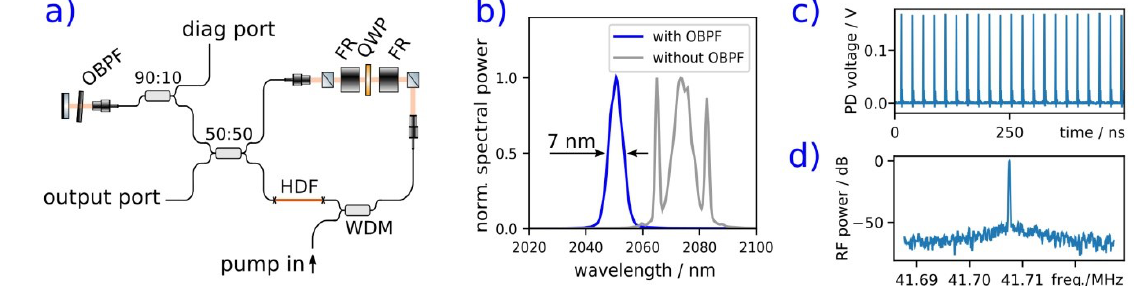
Fig.1 : a) overview of the setup. b) optical spectra of mode-locked operation. c) pulse train in the time domain. d) radio-frequency spectrum (resolution bandwidth 100 Hz) around the repetition